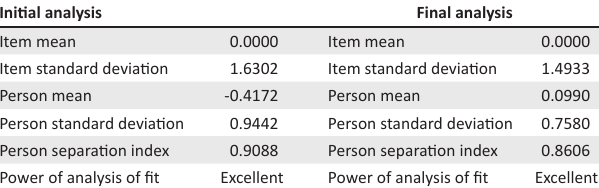
TABLE 3: A comparison of the initial and final analyses. Initial